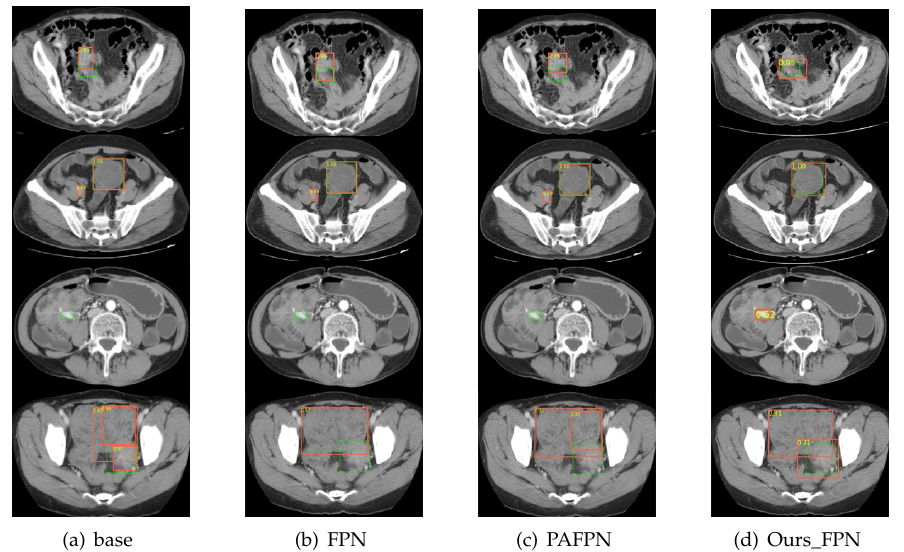
Figure 4. Visual comparison of different feature pyramid networks (the orange bounding box in the figure represents the predicted box, and the green bounding box represents the actual labeled